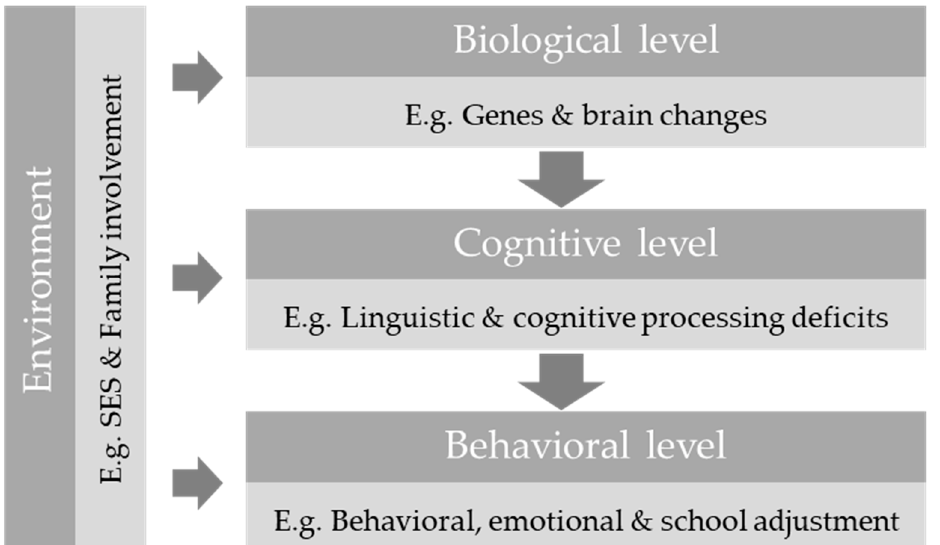
Figure 1. Adaptation of the causal neurodevelopment model of Morton [44].